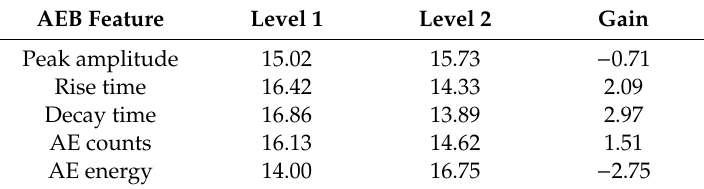
Table 4. Response table for signal-to-noise ratios (SNRS) to sort out useful features.